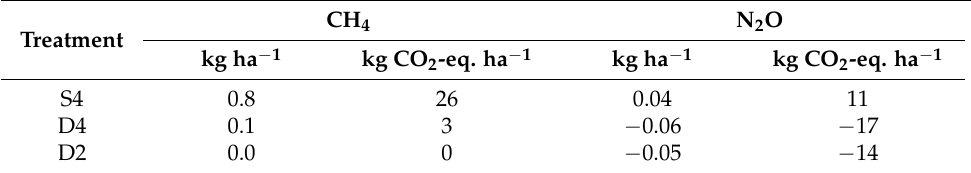
Table 4. Accumulated methane (CH 4 ) and nitrous oxide (N 2 O) emissions over the 44-day period from treatments with: shallow drainage to 0.6 m with weir open four times per week (S4) and deep drainage to 1.2 m with weir open four times per week (D4) or two times per week (D2). Note that a negative value corresponds to accumulated uptake of the